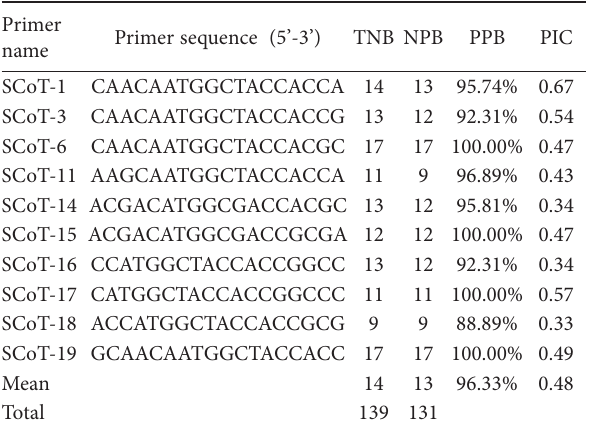
Table 3. SCoT primers used for this study and the extent of poly- morphism.